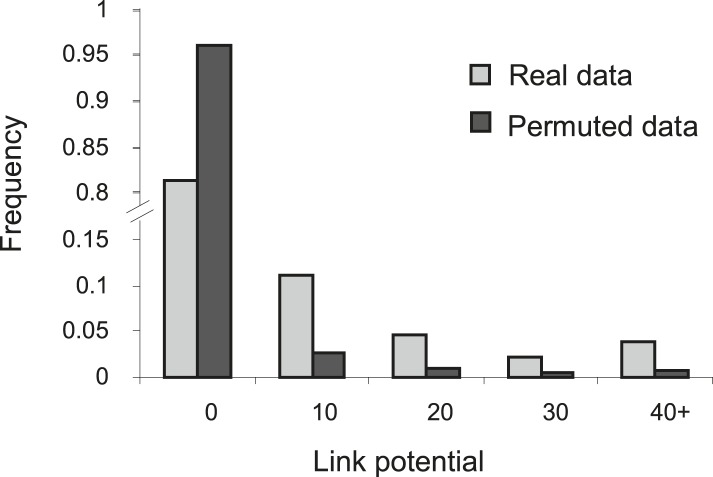
Higher link potential scores for real data than for permuted data.Shown is a histogram representing the frequency (y-axis) of different link-potential ranges (x-axis) generated on the basis of real data (myeloid tissue, gray) compared to permuted data (black; see ‘Materials and methods’).